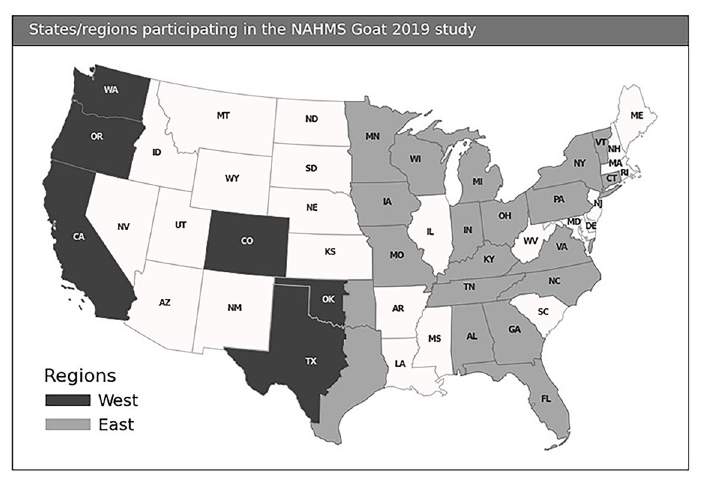
Fig 1. Map of the states and regions for the NAHMS Goat 2019 study. To reflect climate variation and production management, Texas and Oklahoma were divided between the east and west regions roughly on a line corresponding to north-south Interstate 35. The western halves of the states were included in the west region, and the eastern halves were included in the east region. The used and displayed data in that map is the 20m US County boundaries shapefile and are available here: Cartographic Boundary Shapefiles